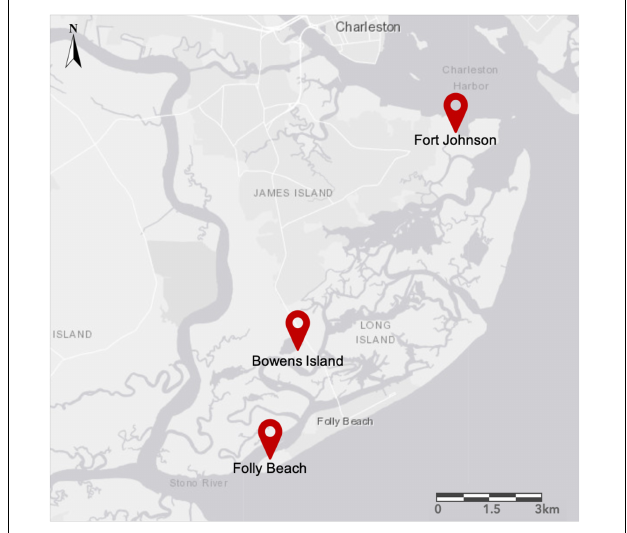
FIGURE 2 | Map of the James Island region near Charleston, South Carolina, United States. We sampled from two habitats (low and high marsh) in three populations: Fort Johnson (FJ), Bowens Island (BI), and Folly Beach (FB).